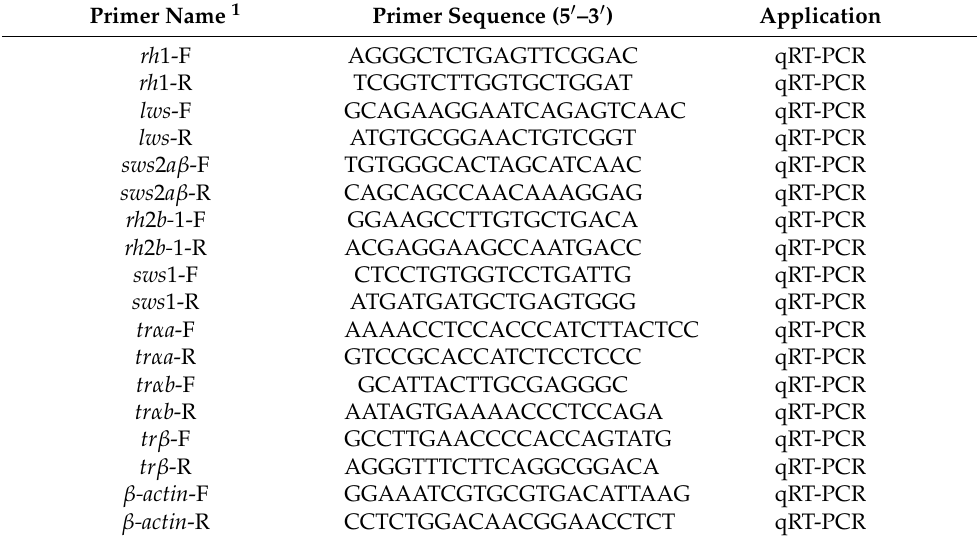
Table 1. Primers used in the